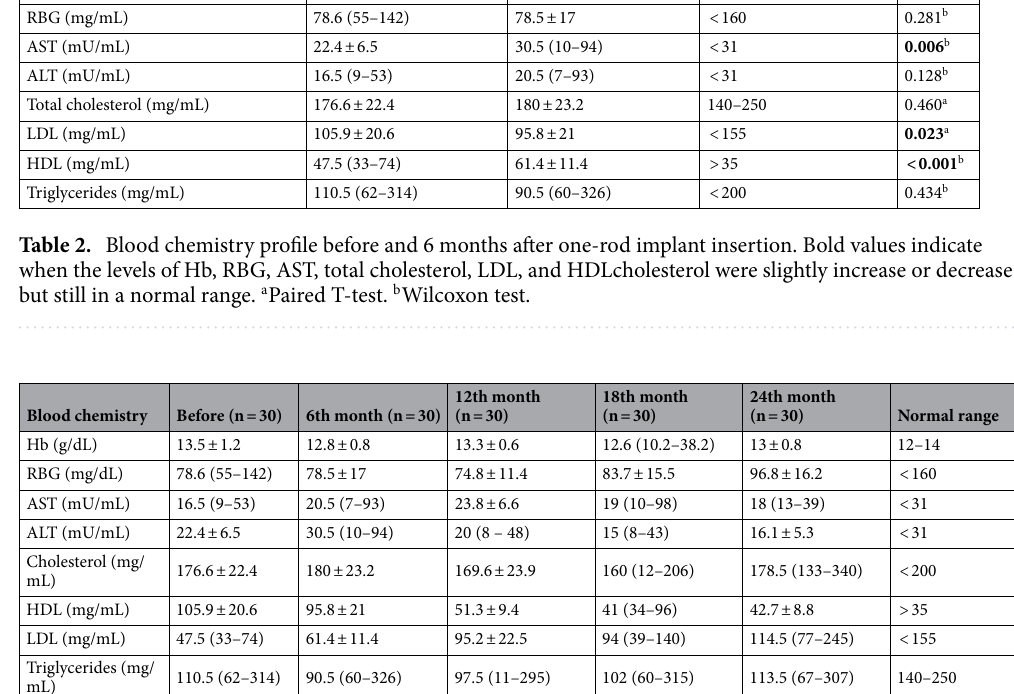
Table 3. The blood chemistry profile during 24 months of follow-up.